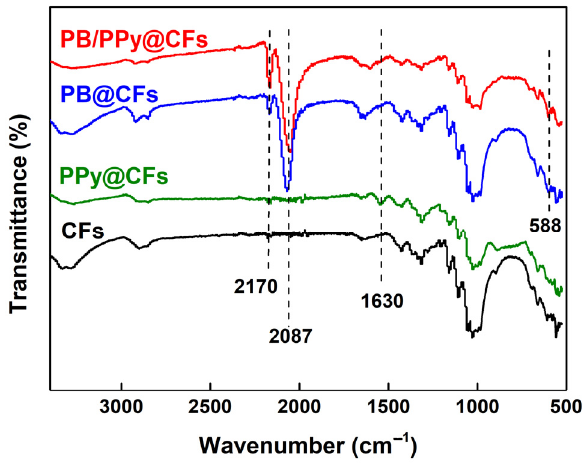
Figure 5. FTIR spectra of CFs, PPy@CFs, PB@CFs, and PB/PPy@CFs.